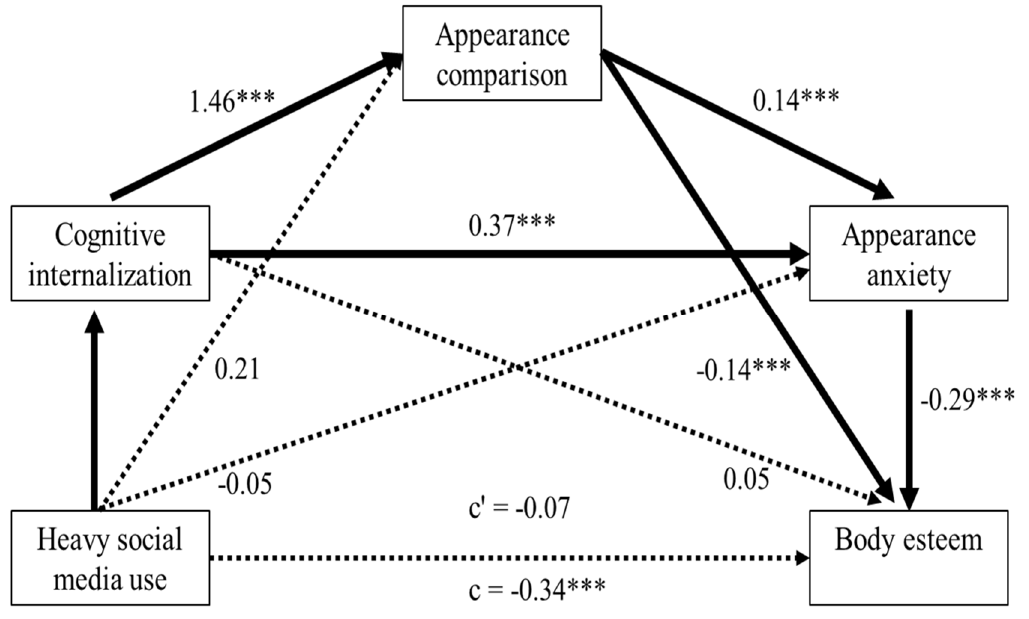
Figure 1. A mediational model that predicts body esteem from excessive social media use (more than 3 h daily), relative to the reference (non-user of social media), via cognitive internalization, engagement in appearance comparison, and social appearance anxiety as serial mediators. c’ represents the relative direct effect of heavy social media screen time on body esteem, and c signifies relative total effect. All values represent standardized regression coefficients. *** p < 0.001.